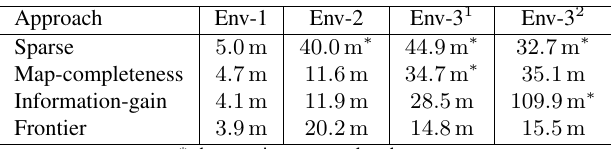
Table 1: Trajectory length comparison in the different environ-